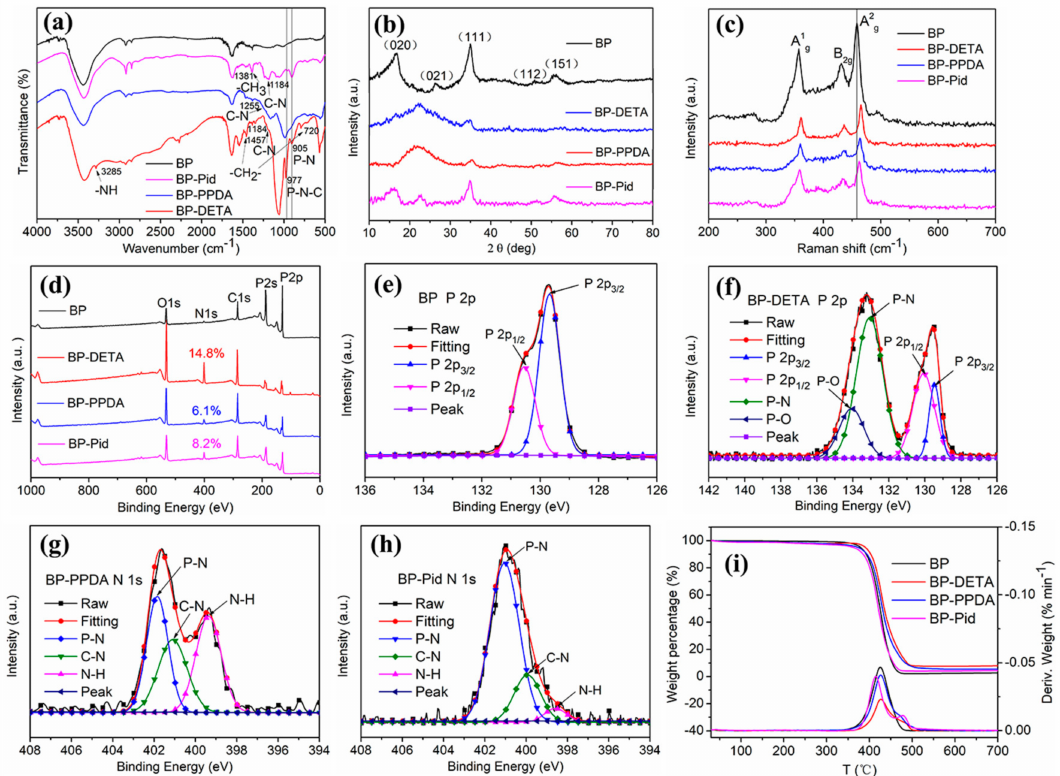
Figure 2. Characterization of BP and BP-NH 2 : ( a ) FT-IR spectra; ( b ) XRD patterns; ( c ) Raman spectra; ( d ) XPS survey spectra and high-resolution P 2p XPS spectra of ( e ) BP nanosheets, ( f ) BP-DETA, ( g ) BP-PPDA, and ( h ) BP-Pid; ( i ) TGA and DTG